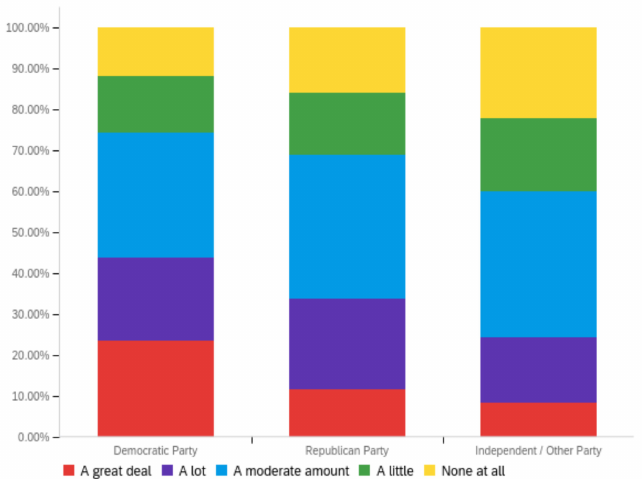
Figure 11. Article controversy level—ideal perception impact by political